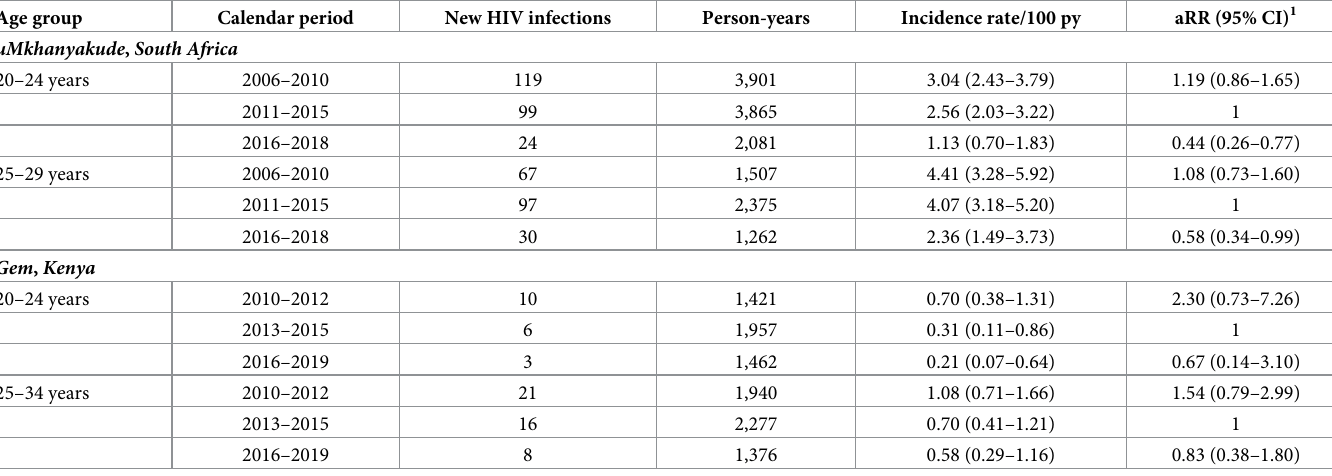
Table 6. Incidence of HIV infection among young men, by age and DREAMS scale-up period in uMkhanyakude, South Africa and Gem, Kenya. Age group